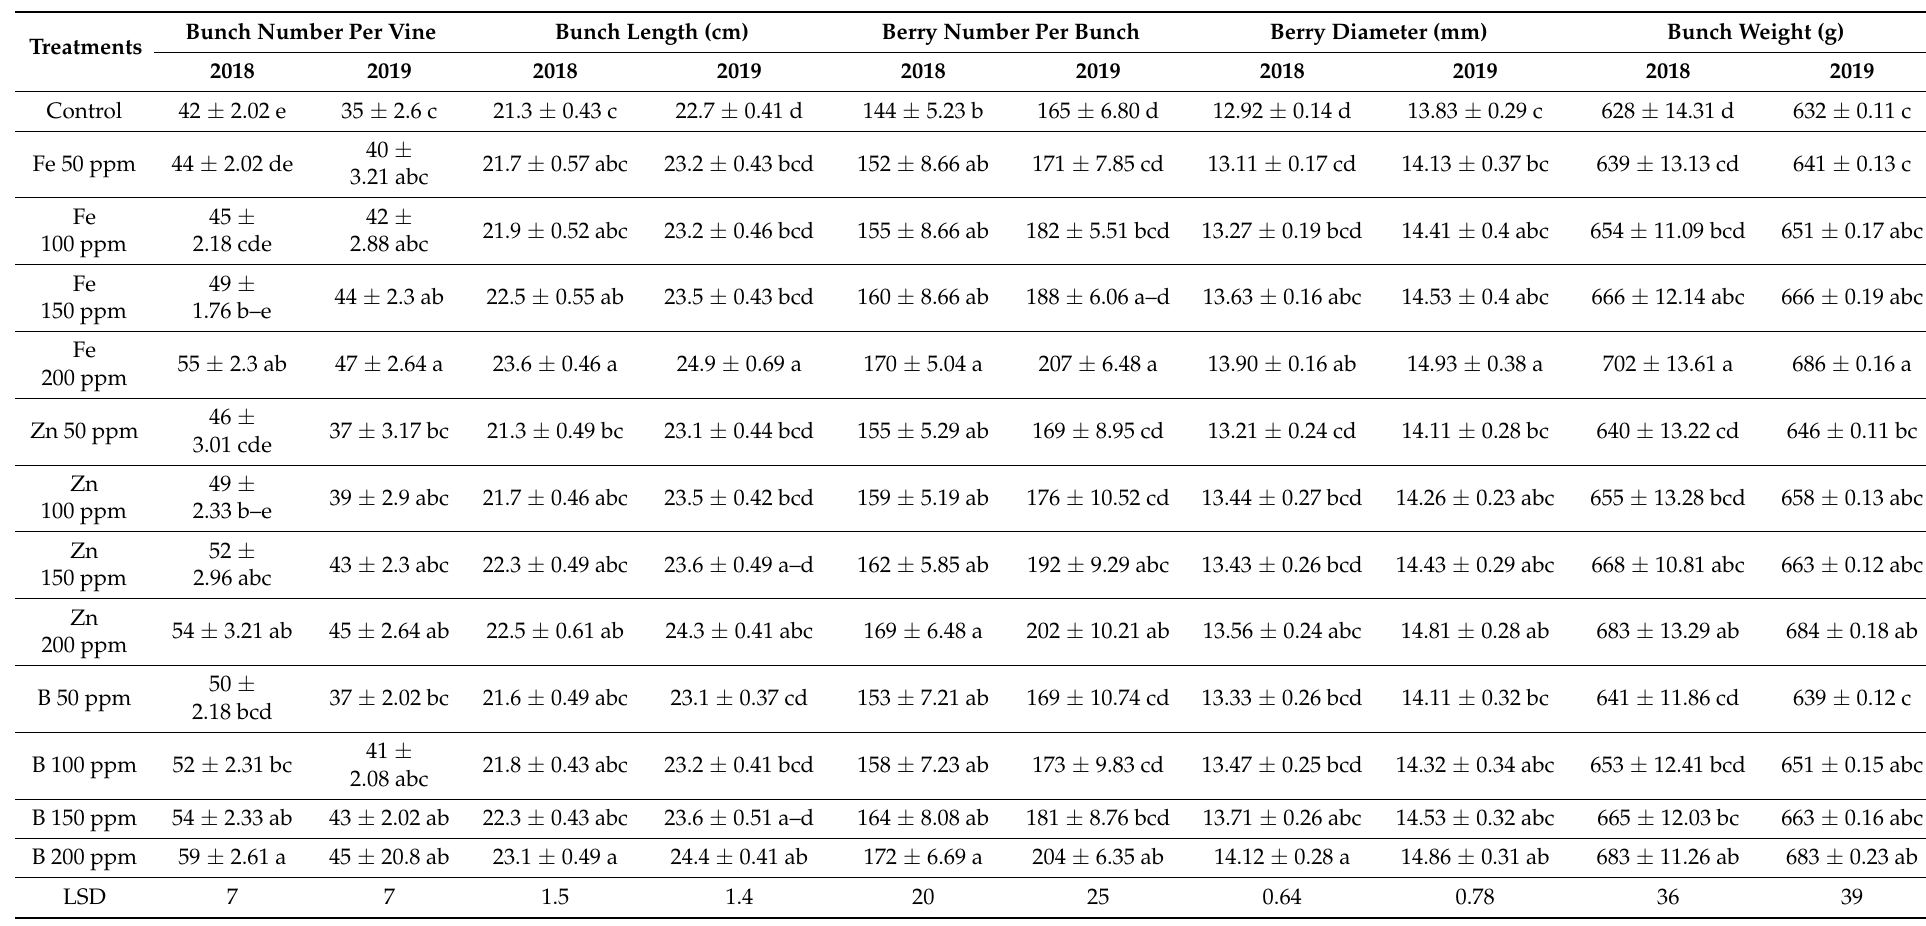
Table 2. Effect of foliar application of micronutrients on yield and physical characteristics of grapes cv. ‘Flame Seedless’ during the years 2018 and 2019. Bunch Number Per Vine Bunch Length (cm) Berry Number Per Treatments